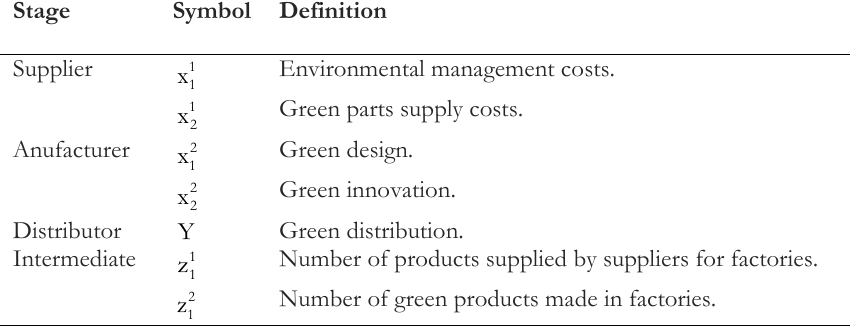
Table 2. Factors used in green supply chain